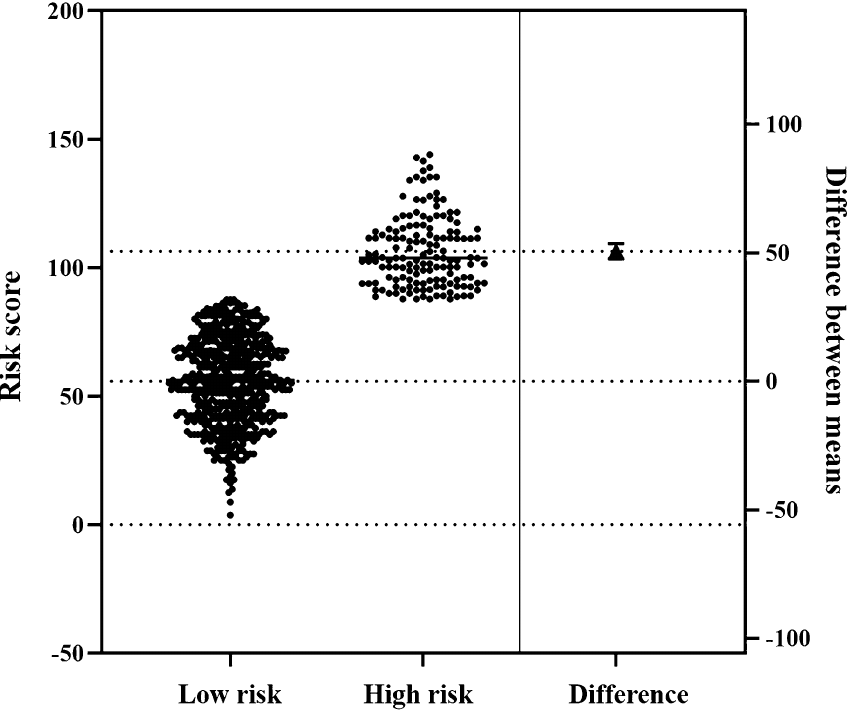
Figure 7. Description of risk scores in low-risk group and high-risk group. The small dots represent the risk score for each patient; The triangle represents the difference of the average scores between the two groups.